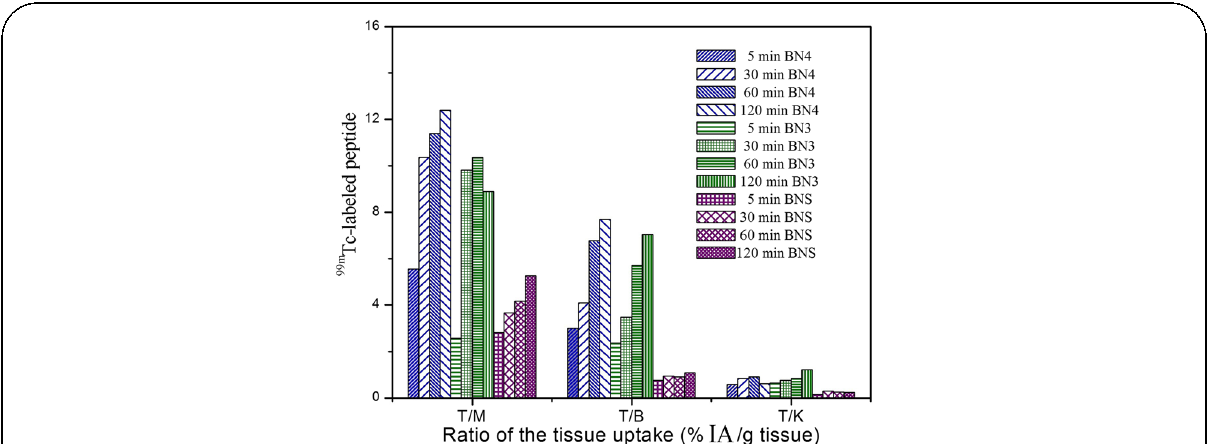
Fig. 10 Comparative tumor to non-target tissue ratios of 99m Tc-BN3, 99m Tc-BN4, and 99m Tc-BNS in MDA-MB-231-induced tumor-bearing mice at 5, 30, 60, and 120 min post injection. T/M: tumor to muscle, T/B: tumor to blood, and T/K: tumor to kidney. All the data represent %IA/g values and each values are the mean ± SD of three animals per time point ( N =